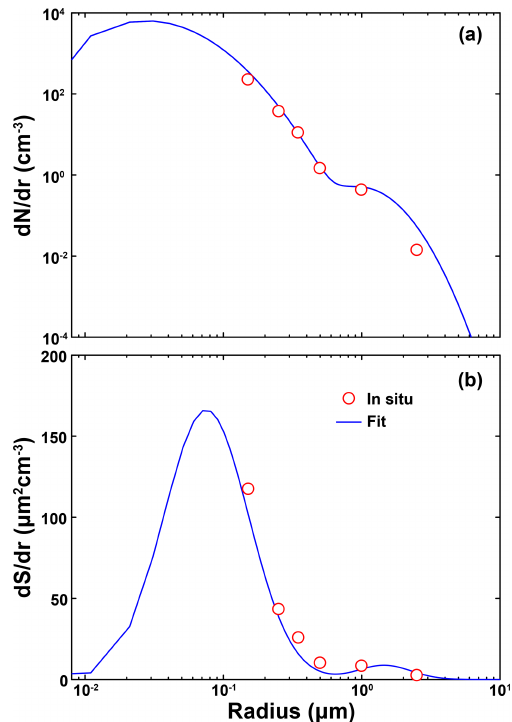
Figure 3. (a) The number size distribution used for the estimation of the corrected n 250 , dry (number concentration of particles with radius larger than 250nm) and (b) the corresponding surface size distribution used for the estimation of the corrected S dry (surface concentration of all particles). In situ measurements are denoted by red circles while the blue lines give the bimodal lognormal fit on the measurements. The example refers to the UAV-OPC data acquired at 1.2km at 10:45UTC on 5 April 2016 (see Fig.